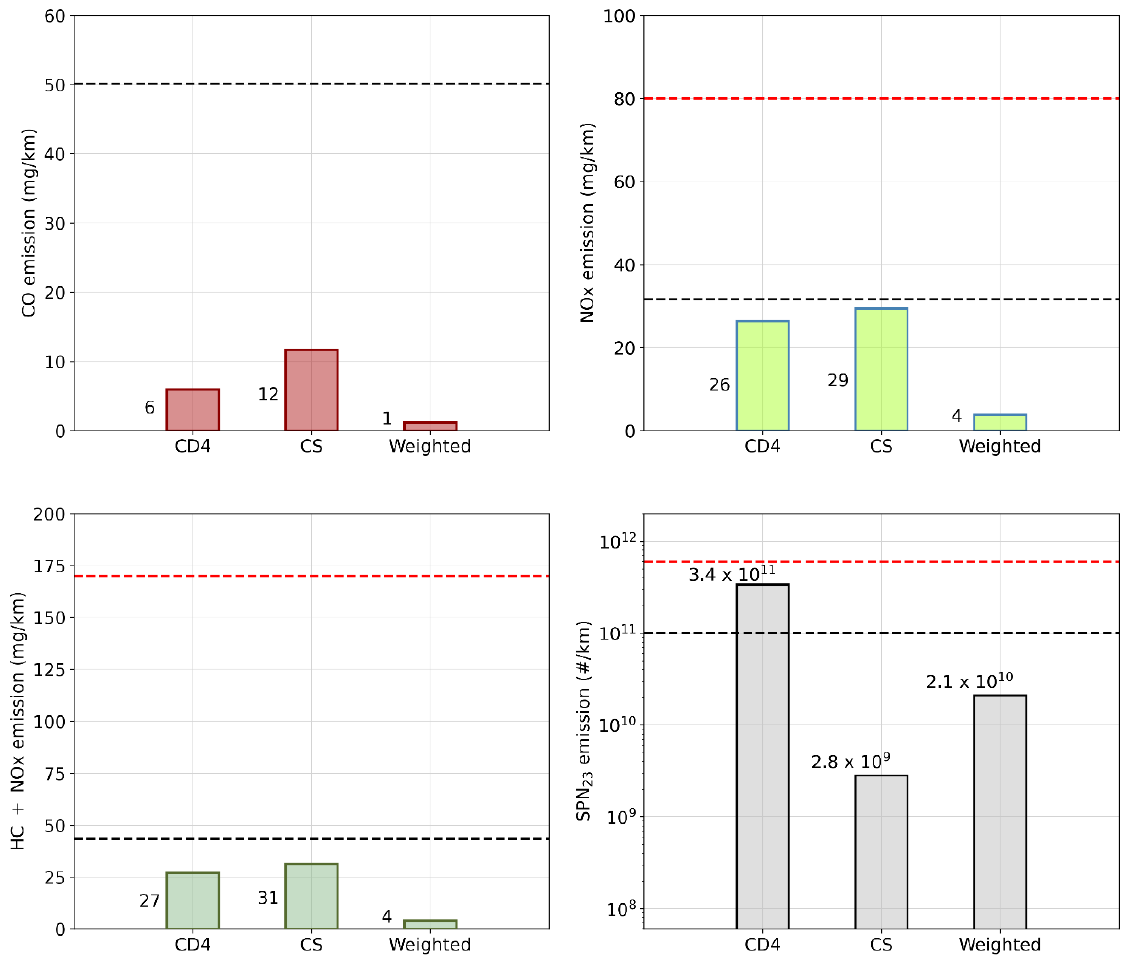
Figure 1. Regulated emissions on WLTP at 23 ◦ C. CD4 indicates the 4th cycle in the charge depleting sequence (i.e., the cycle in which the ICE ignited for the first time), started with a battery initial State of Charge (SOC) equal to 100%; CS indicates the cold start charge sustaining cycle performed after the battery depleting sequence, i.e., starting with the minimum SOC. Red dashed lines represent the Euro 6 regulatory limits (500 mg/km for CO not reported), black dashed lines represent average emissions from the fleet of Diesel vehicles tested at the JRC in the 2020–2021 period, in the framework of the Market Surveillance (MaSu) activity on the same cycle. All tests were performed in the default user selectable mode of operation. See Methods section for additional details.